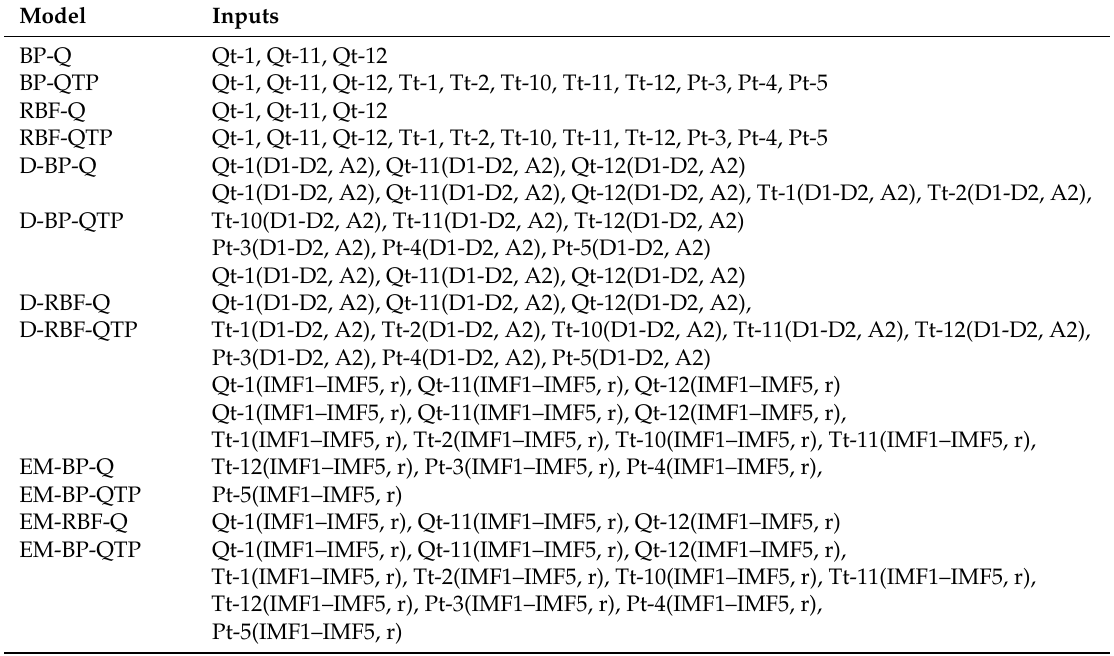
Table 3. Models and their corresponding inputs for zone one.